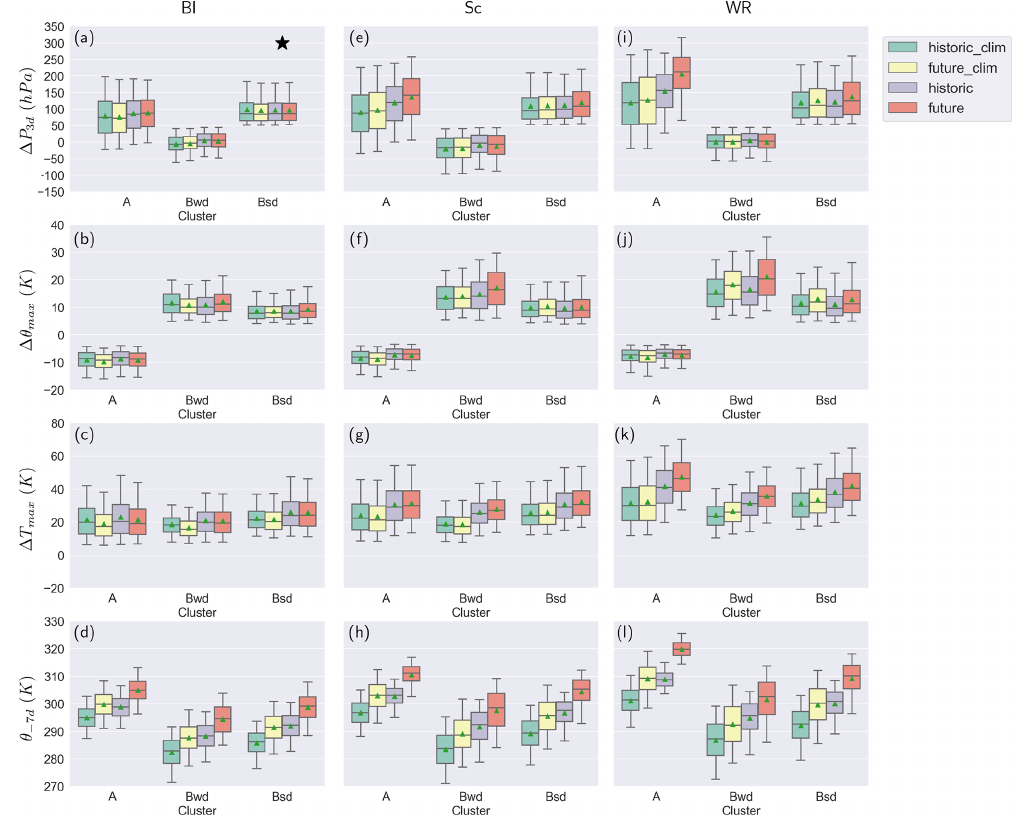
Figure 13. Trajectory properties of clusters (defined in Sect. 2.4) calculated on heatwave days in comparison to climatological (JJA) values in different European regions: (a–d) BI, (e–h) Sc and (i–l) WR. The top row shows the difference in pressure (cid:49)P 3d 3d prior to the heat event/prior to arrival in the target region, the second row from top shows the maximum change in potential temperature (cid:49)θ max along the trajectory, the third row from top is the maximum change in temperature (cid:49)T max along the trajectory and the bottom row is the potential temperature 7d prior to the arrival in the respective region. Historic (light purple, third boxes) and future (red, fourth boxes) refer to air parcels started on heatwave days; historic_clim (green, first boxes) and future_clim (yellow, second boxes) show the JJA climatology. Black stars above the boxes indicate that the difference between the means of either future and historic heatwaves or climatologies is insignificant ( p value of 0.05 based on a t test). All other means are significantly